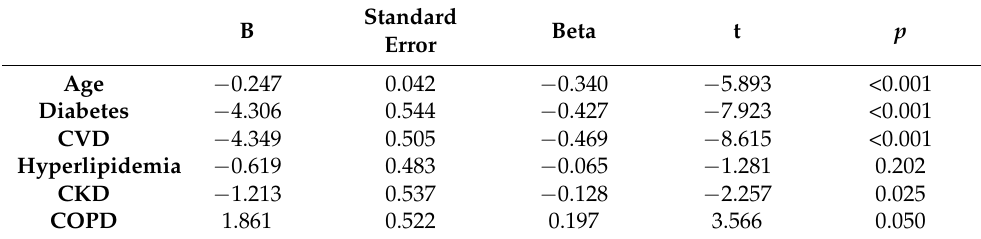
Table 2. Linear regression analysis with the MoCA score as dependent